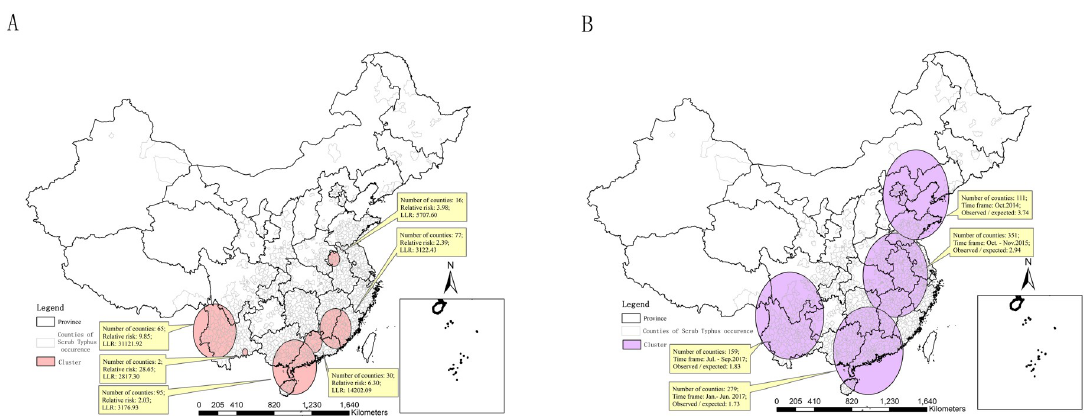
Fig 6. Space-time scan statistic analyses for scrub typhus. A. the purely spatial analysis scanning in 12 years. B. the retrospective space- time analysis scanning from 2006 to 2017. (The vector data of Chinese administrative divisions were provided by CNNDS. Figure 6 was created for this manuscript using ArcGIS.).